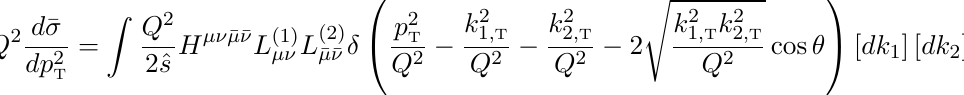
JHEP12(2017)097